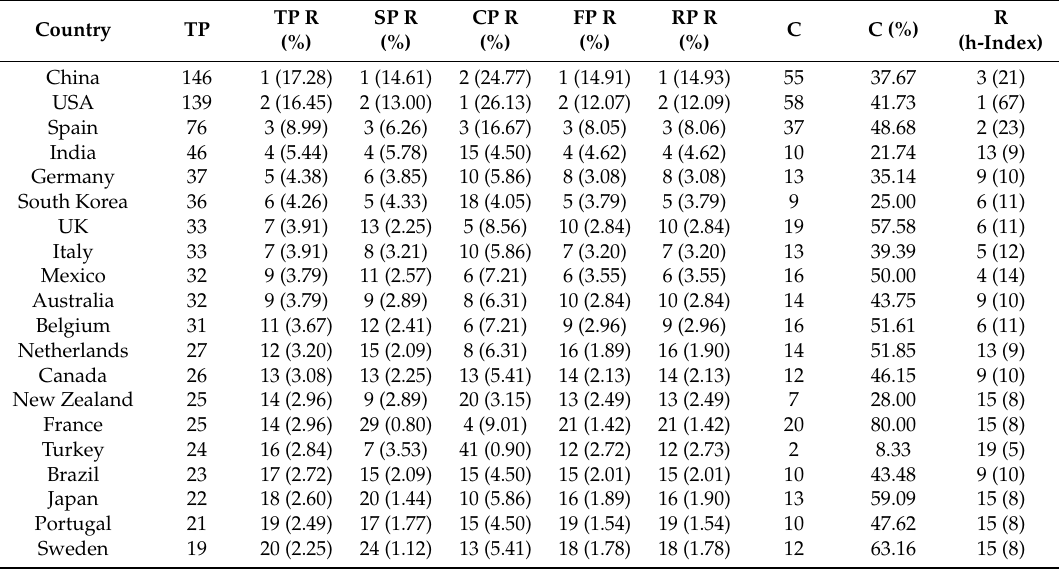
Table 4. Top 20 productive countries/territories during